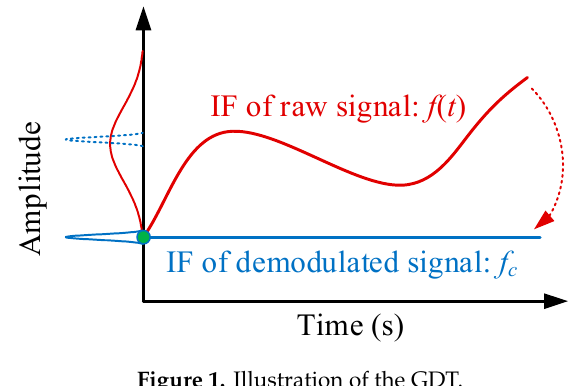
Figure 1. Illustration of the GDT.